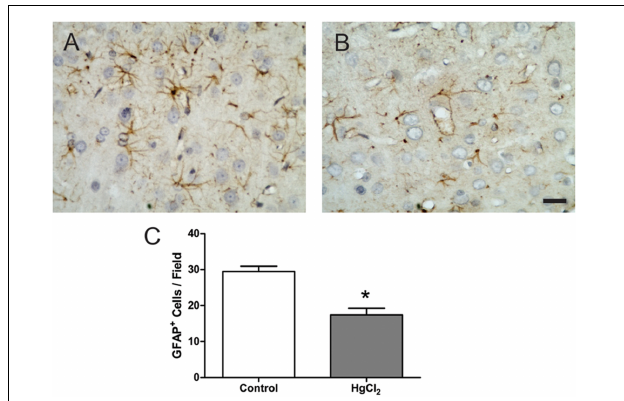
FIGURE 9 | Effects of chronic exposure to HgCl 2 on astrocyte density in the motor cortex of adult Wistar rats. (A,B) Represent photomicrographs of the GFAP-labeled motor cortex of control animals (A) and exposed animals (B) . Results are expressed as mean ± standard error of the number of cells counted per field (C) . ∗ p < 0.05 compared to the control group (Student’s t -test). Scale bar 20 µ m.